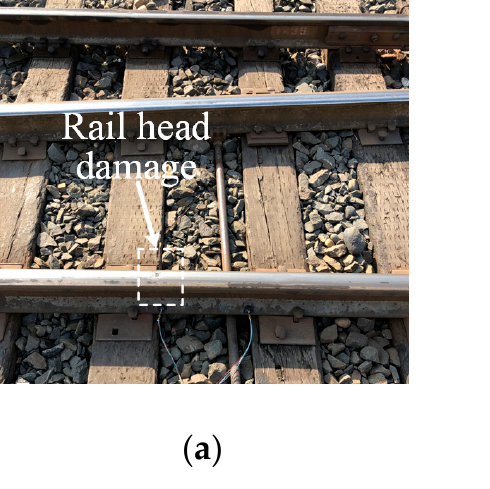
Figure 4. Target damage and experimental scheme: ( a ) target damage; ( b ) experimental scheme.